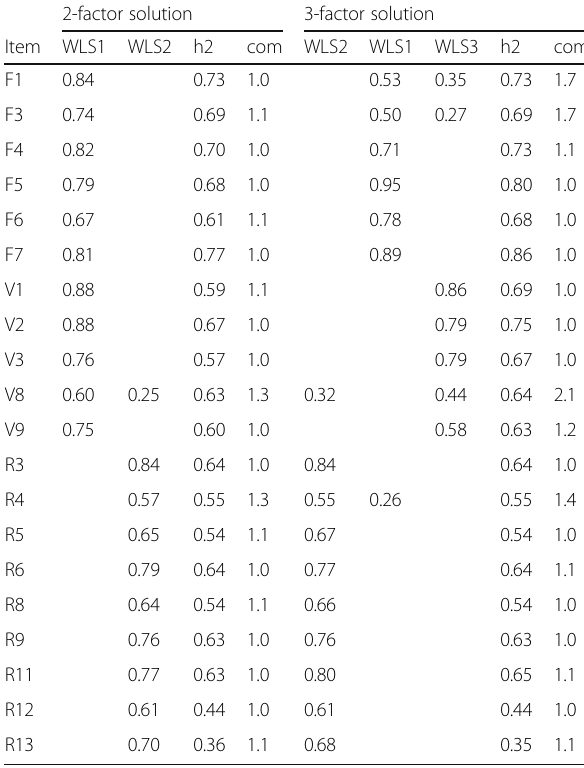
Table 4 Pattern matrix from 2- and 3-factor solution from the third round of EFAs 2-factor solution 3-factor